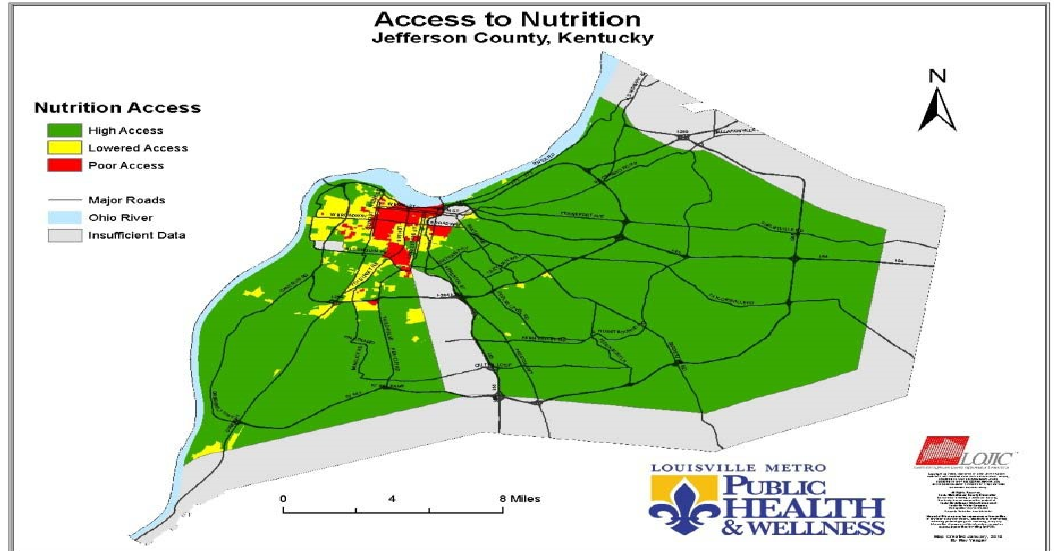
Figure 1. Food desert neighborhoods in Jefferson County, Kentucky, where the city of Louisville is located. (Source: Lou- isville Metro Public Health & Wellness). Scale: 0–6.4 km (4 miles).